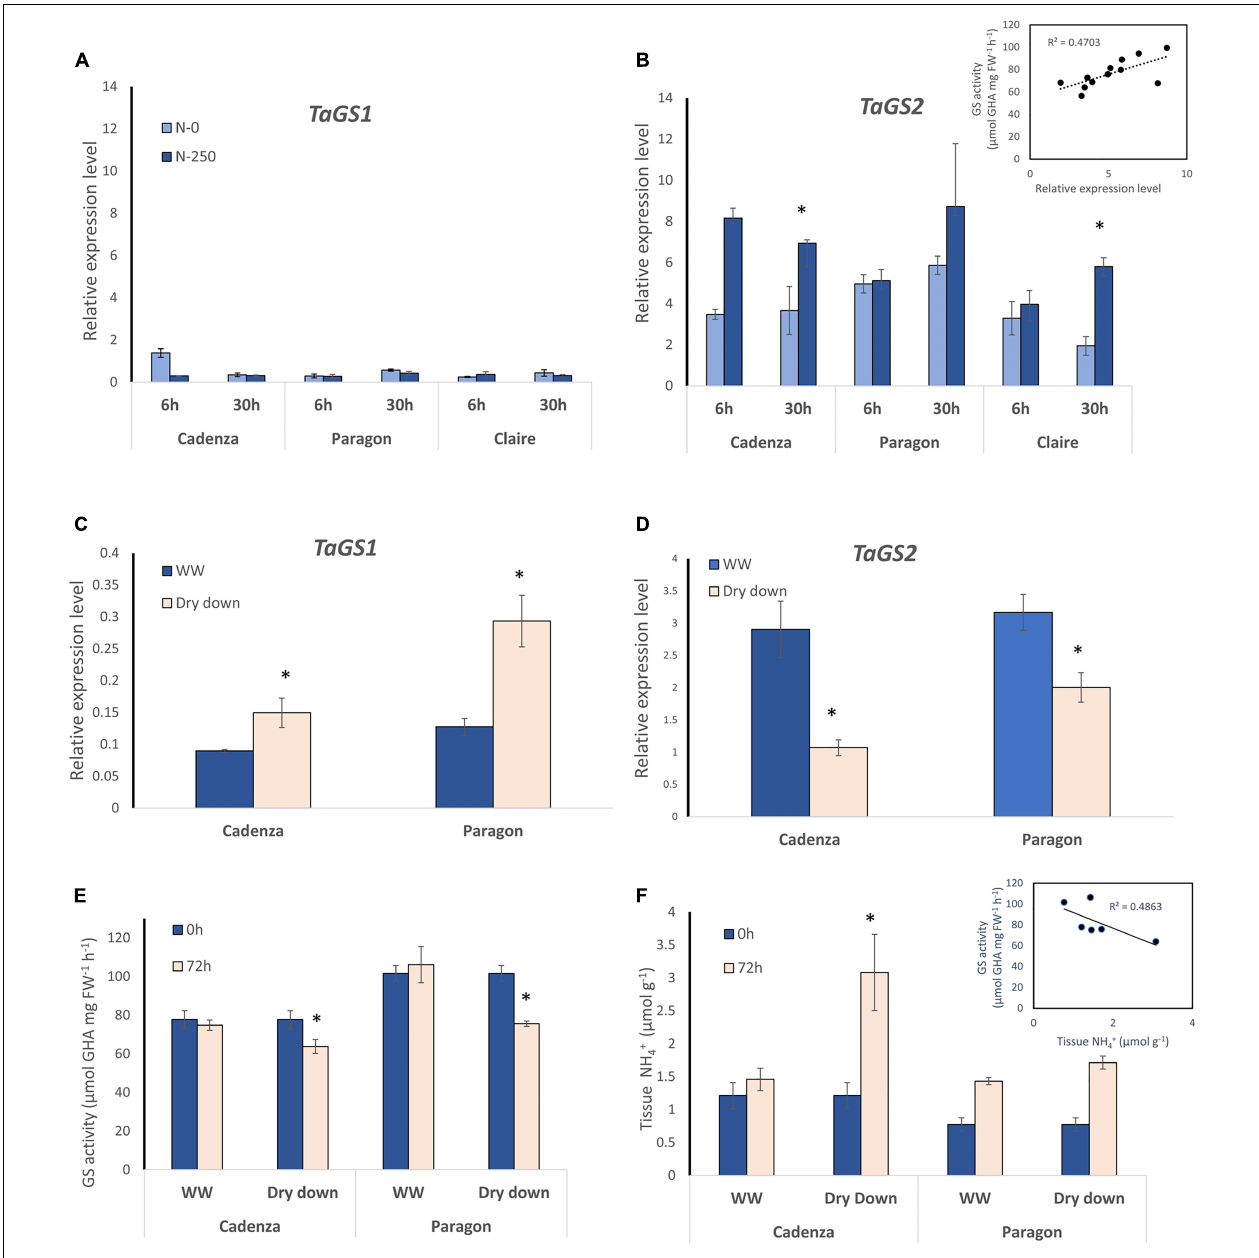
FIGURE 3 | GS1 and GS2 gene expression analysis in response to N and water deficit. For gene expression analyses, specific primers were designed that specifically amplify the GS1 genes and GS2 genes, respectively (see Figure 2 ). Expression of the three GS1 genes and their corresponding homeologs (A) and the GS2 gene with its three homeologs (B) was quantified in leaf samples from the four indicated wheat genotypes at 6 h and 30 after NH 4 NO 3 application equivalent of 250 kg N ha − 1 (N250) and in water-treated control plants (N-0). Each value represents the mean ± SE of four biological replicates. The inlay in (B) shows the correlation of GS gene expression and GS enzyme activity (corresponding GS activity data are shown in Supplementary Figure 4 ). The response of GS1 (C) and GS2 (D) gene expression to a dry-down treatment was analysed at 72 h after withholding water. Well-watered (WW) plants were sampled in parallel. Each value represents the mean ± SE of four biological replicates. In the dry-down experiment, GS enzyme activity (E) and leaf tissue ammonium content (F) were measured in parallel at 0 h and at 72 h after withholding water. The inlay shows a negative correlation of tissue ammonium and GS activity. Each value represents the mean ± SE of six biological replicates. Asterisks indicate significant differences between means ( p < 0.05) of each treatment.